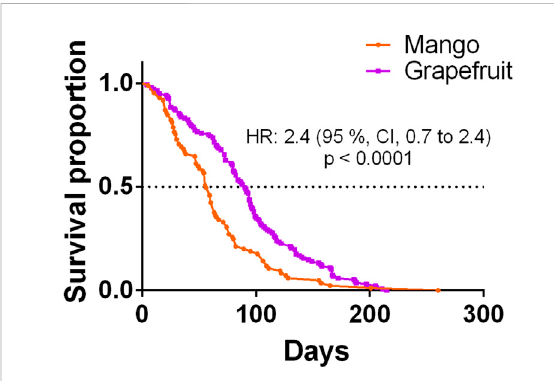
FIGURE 7 Kaplan-Meier survival curves of Anastrepha ludens females andmalesoriginatingfromtwohostplants(mangocv. ‘ Manila ’ and grapefruit cv. ‘ Marsh ’ ) under fi eld conditions.